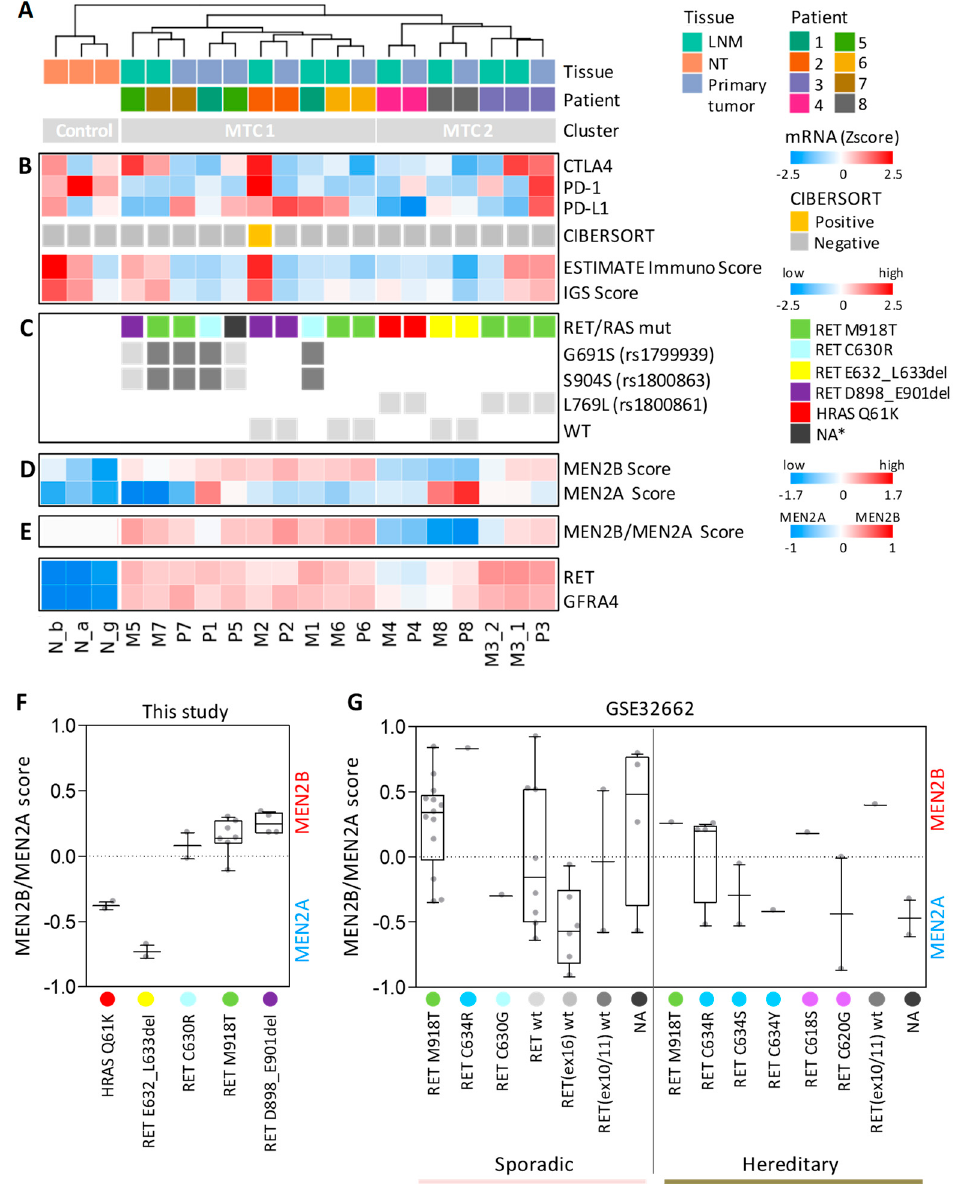
Figure 5. Assessment of immune- and MTC-related gene signatures in our sporadic MTC cohort. ( A ) Unsupervised hierarchical clustering as reported in Figure 4A. LNM, lymph node metastasis; NT, non-neoplastic thyroid. ( B ) Expression of immune-related genes and signatures. CIBERSORT class attribution according to p -value (<0.05, positive; ≥ 0.05, negative). ESTIMATE Immunoscore expressed as normalized data (Zscore). Immune gene signature (IGS) score calculated as mean expression of the 18 IGS genes. ( C ) RET/RAS mutational status. NA *, not available data (this sample is the matched specimen for M5 LNM-harboring RET D898_E901del). Specific RET SNPs or their absence (WT) is indicated in grey. Dark grey indicates homozygosis. ( D ) Gene expression scores calculated separately for MEN2B and MEN2A upregulated genes, respectively. ( E ) Combined score for the attribution of either MEN2B-like or MEN2A-like type based on MEN2B/MEN2A signature. ( F ) MEN2B/MEN2A score in our sporadic MTCs stratified for driving lesion. All the specimens (primary tumor and LNM) are shown for each patient. ( G ) MEN2B/MEN2A score in the public MTC GSE32662 series stratified for MTC subtype and driving lesion.